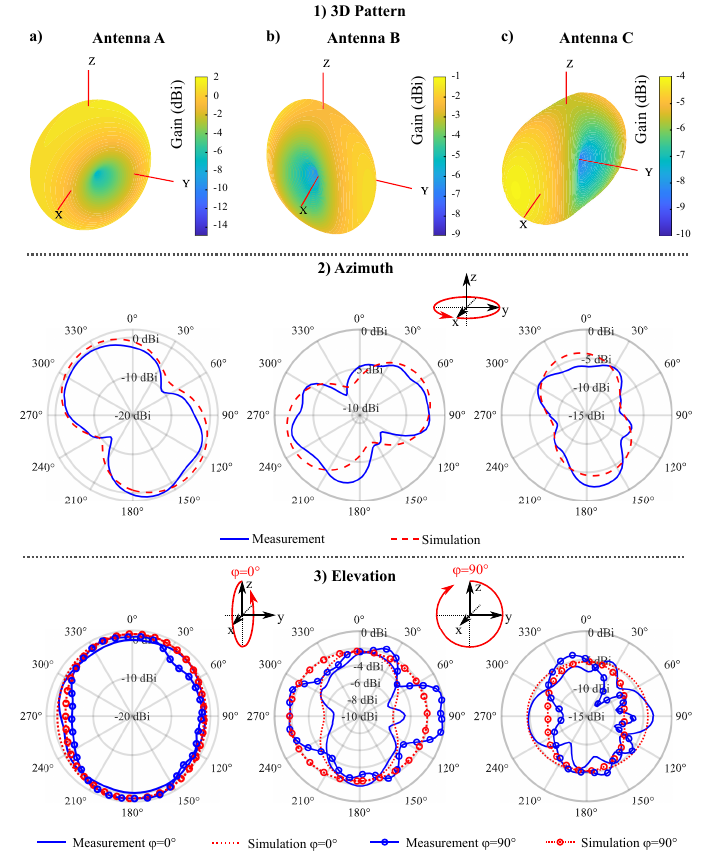
Figure 5. Simulated 3D antenna gain pattern ( 1 ) and the simulated and measured azimuth ( 2 ) and elevation antenna gain patterns ( 3 ) for the antennas A ( a ), B ( b ) and C ( c ) depicted in Figure 3a–c. Antenna A exhibits a simulated maximum gain ( G sim ) of 1.3 dBi compared to a measured maximum gain of 1.49 dBi ( G meas ). The mean absolute error (MAE) of the gain at azimuth angles is 1.32 dB, the MAE of the gain at elevation angles at ϕ = 0 ◦ is 0.92 dB and at ϕ = 90 ◦ 1.03 dB. The results of Antennas A–C are presented in Table 2. Table 2. Comparison of measured and simulated antenna